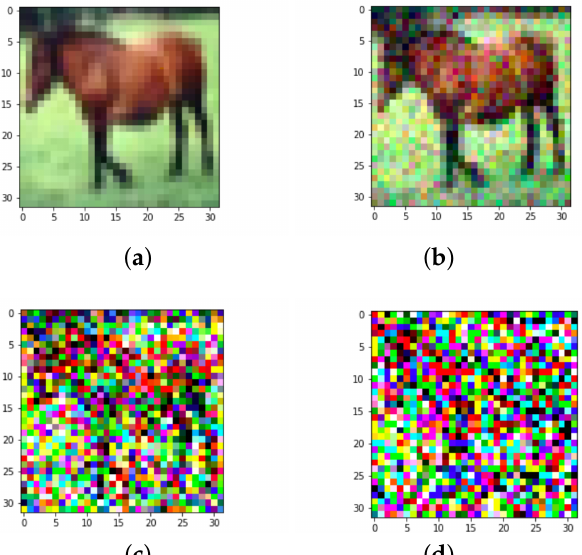
Figure 6. Examples of CIFAR images corrupted by various amounts of additive Gaussian noise as used in our experiments. ( a ) Original, no noise. ( b ) Gaussian noise, zero mean, 0.1 STD. ( c ) Gaussian noise, zero mean, 0.5 STD. ( d ) Gaussian noise, zero mean, 1.0